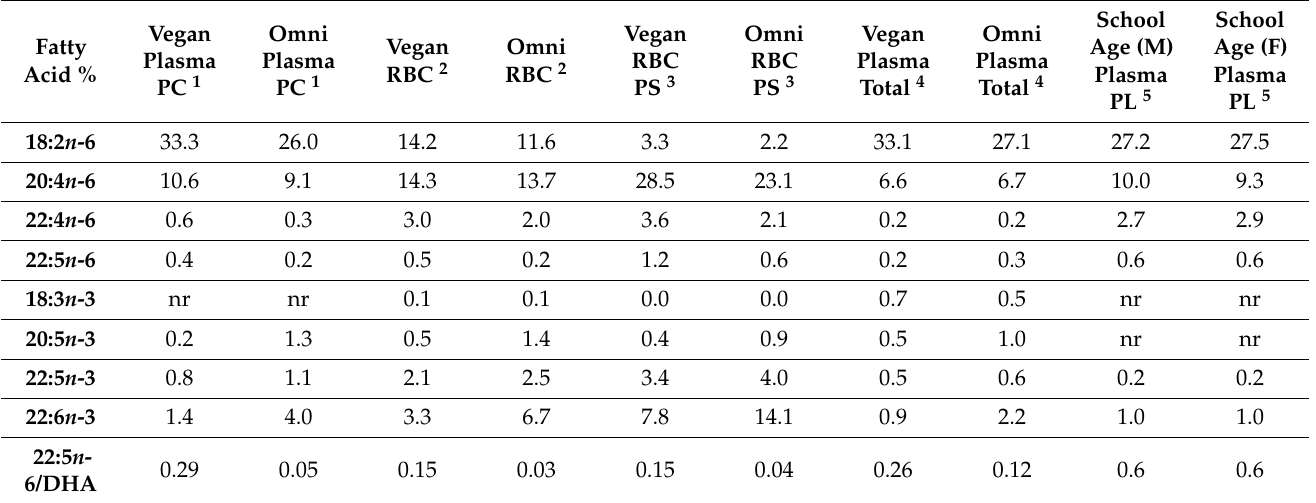
Table 3. Plasma and red blood cell polyunsaturated fatty acids in vegans and omnivores (% total fatty